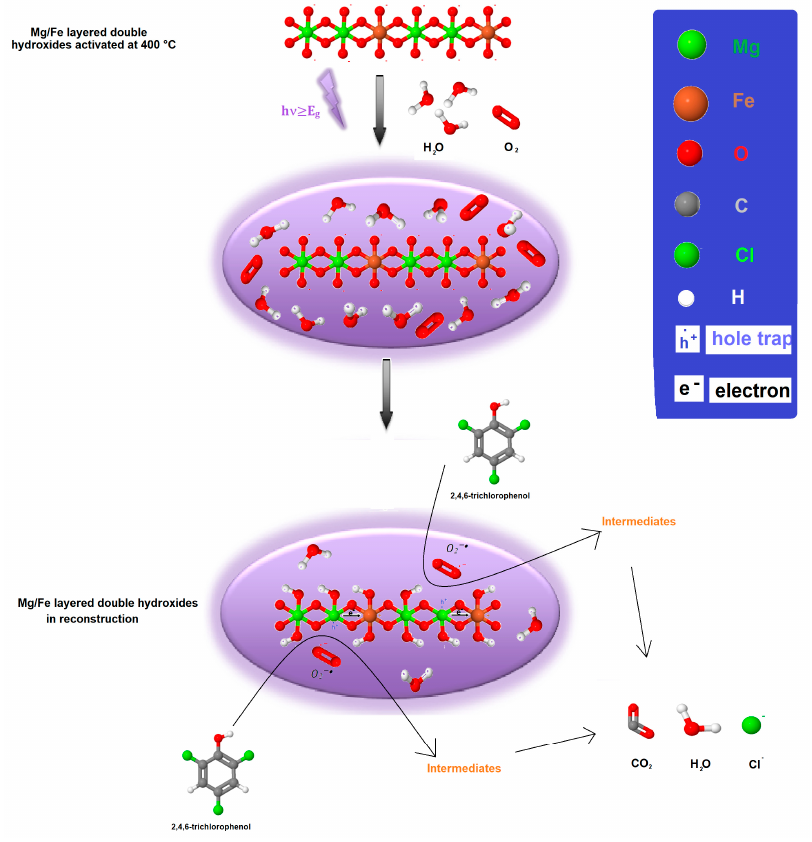
Figure 16. Possible routes for the degradation / mineralization of 2,4,6-trichlorophenol by activated layered double hydroxides.